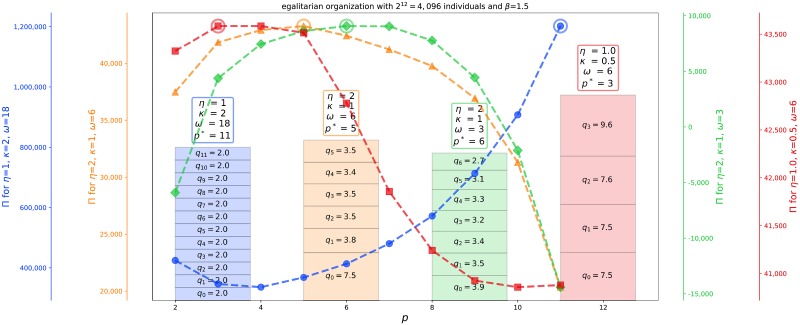
Production Π(p) as a function of p (number of hierarchical levels minus one) for four different sets of parameters for a total population of 212 = 4096 collaborators.For each of the four parameter set indicated in the four legends along the vertical axis, we obtain the optimal group sizes {q0, …, qp}, and calculate the corresponding total production Π(p) from expression (6). The function Π(p) exhibits a maximum at some p = p* indicated with an open circle. For each of the four optima, the corresponding optimal group sizes {q0, …, qp*} are given in the form of a stack of rectangles put on top of each other. The four different sets of parameters span different regimes and thus hierarchical designs. Non-integer values of qr’s should be interpreted as a combination of group of integer numbers of collaborators, with numbers within one unit from the quoted qr and such their average value is as close as possible to the qr. For instance, qr = 3.7 or 3.8 should be interpreted as corresponding to three groups of 4 and one group of 3. See main text for a detailed description of the four different cases.